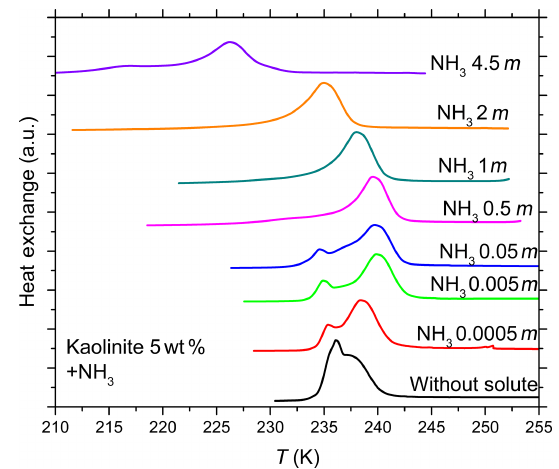
Figure 5. DSC thermograms of 5wt% kaolinite particles suspended in ammonia solution droplets (0–4.5molal; a w equal to 1–0.922). All curves are normalized such that the areas under the heteroge- neous and homogeneous freezing curves sum up to the same